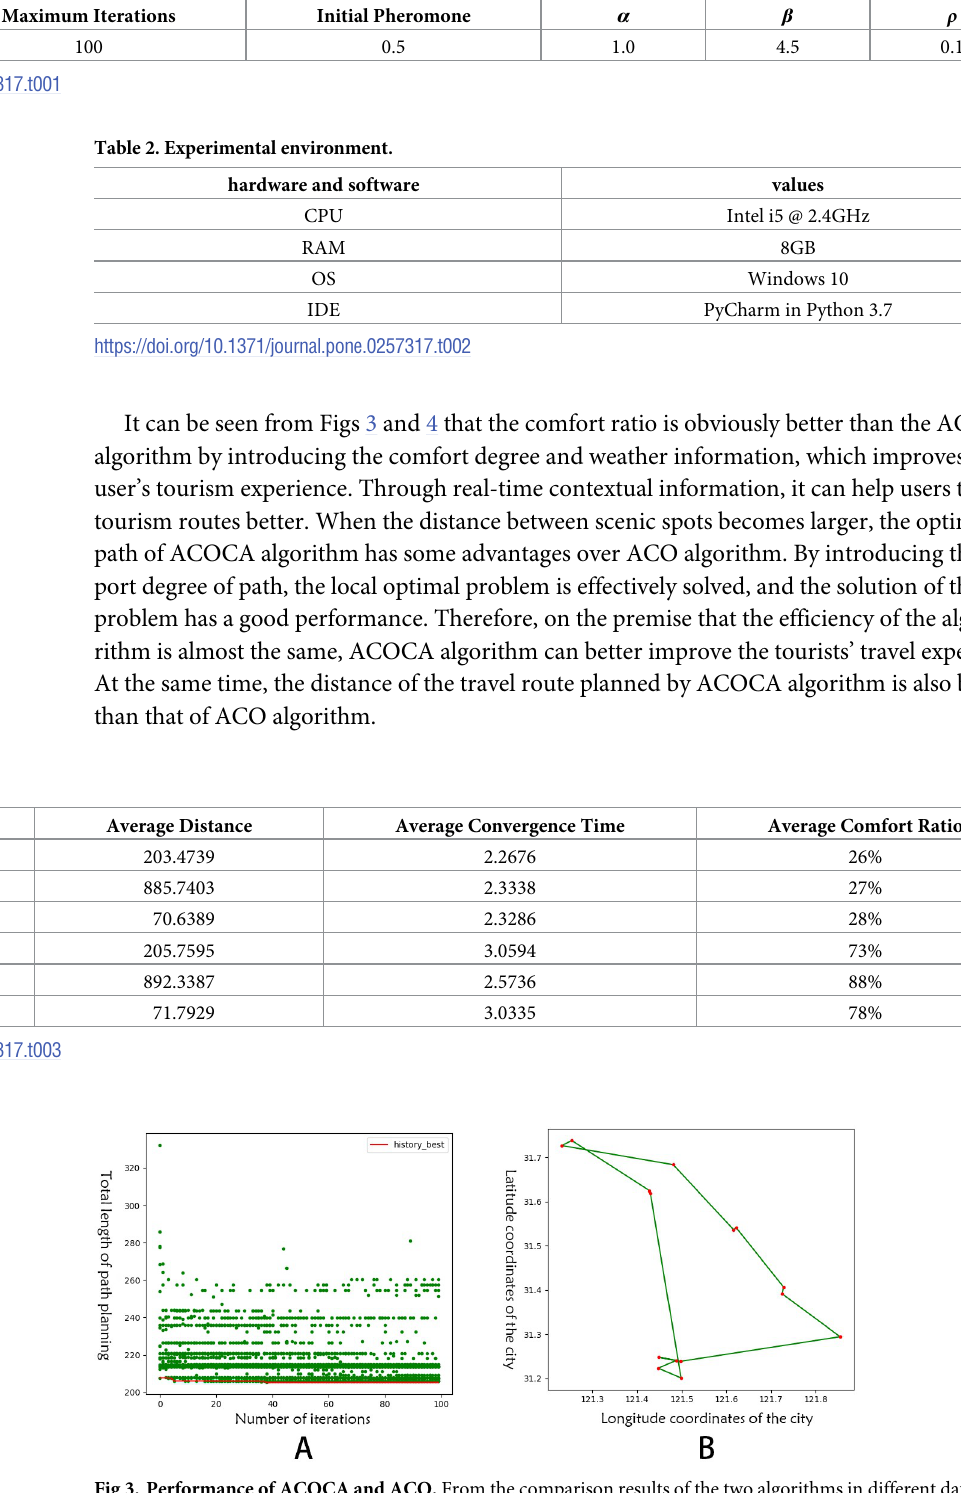
Fig 3. Performance of ACOCA and ACO. From the comparison results of the two algorithms in different datasets, the distance of ACOCA algorithm is better than that of ACO algorithm.